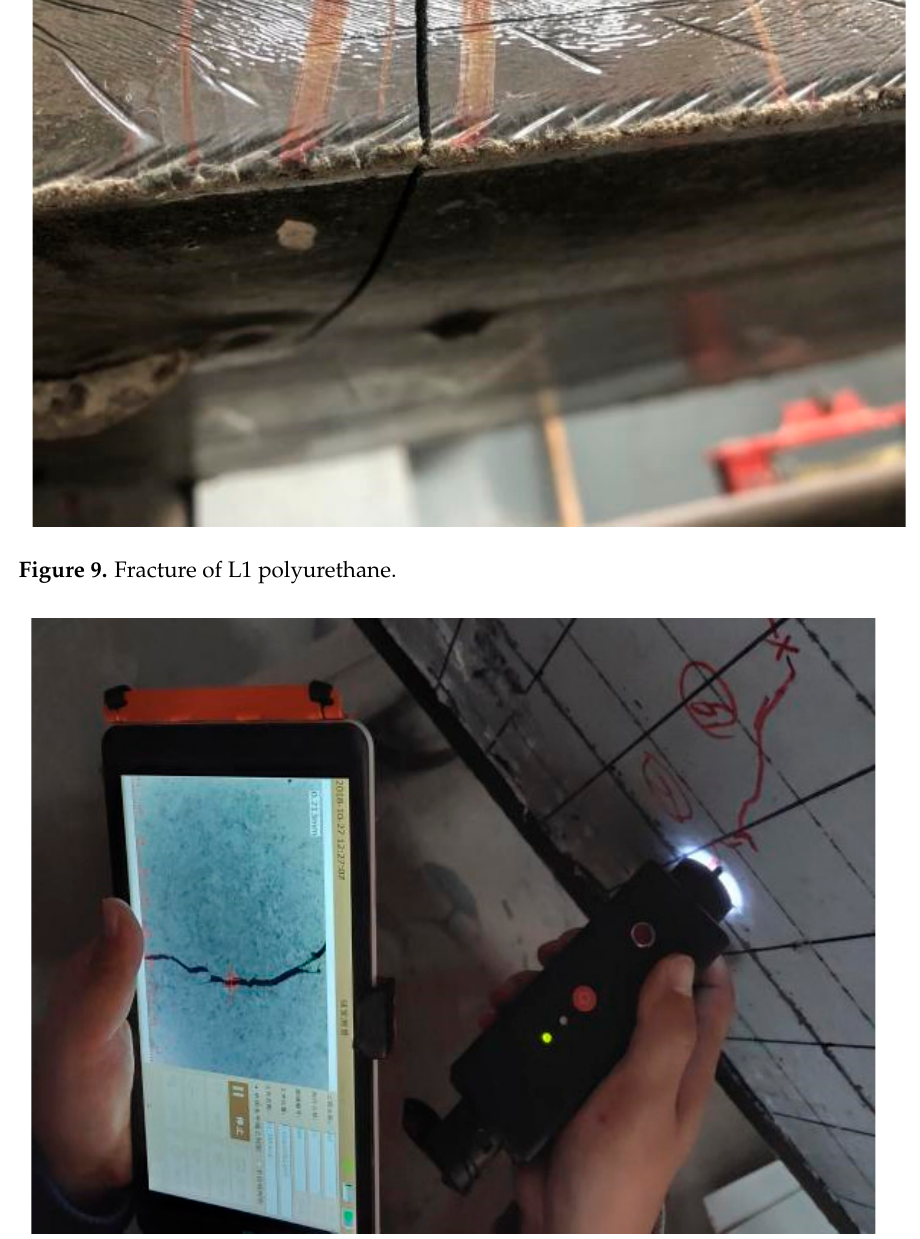
Figure 10. Crack opening assessment for L2 beam body.